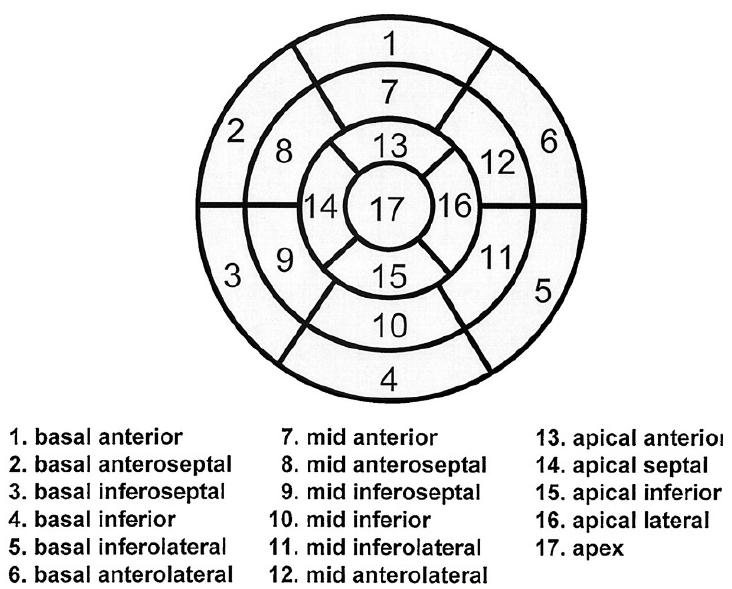
Figure 1. Left ventricular segmentation (17-segment model) [10]. Reprinted/adapted with permission from Ref. [10]. Copyright year 2002, copyright owner American Heart Association, Inc..